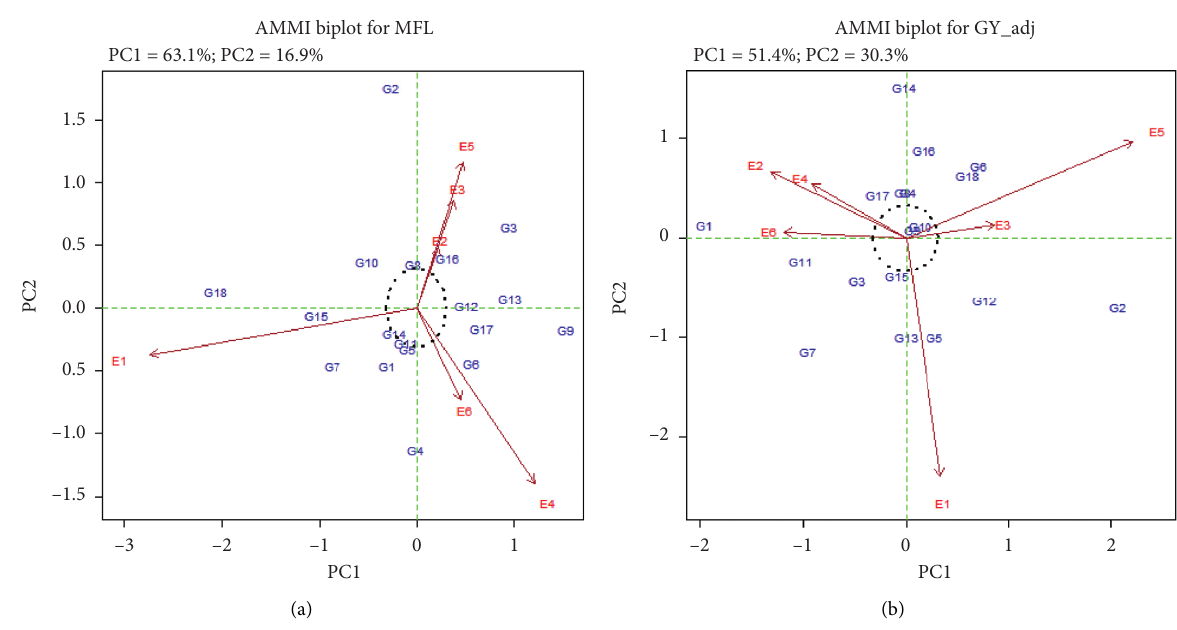
Figure 1: AMMI-2 biplot: (a) male flowering; (b) grain